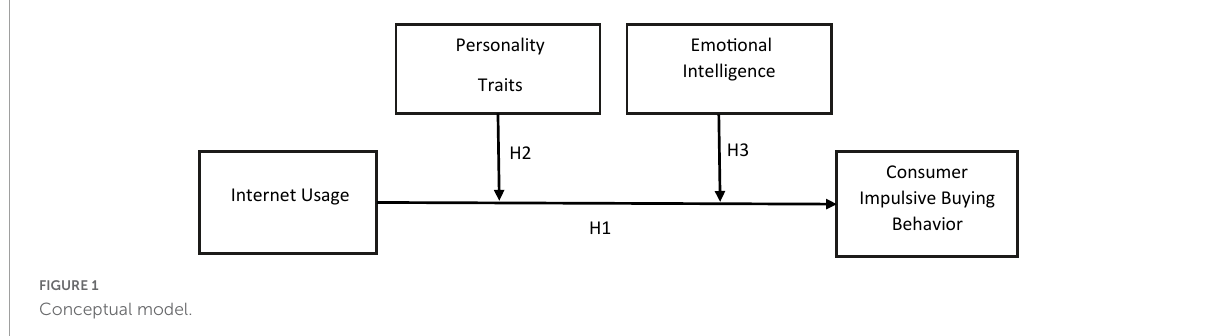
FIGURE1 Conceptual